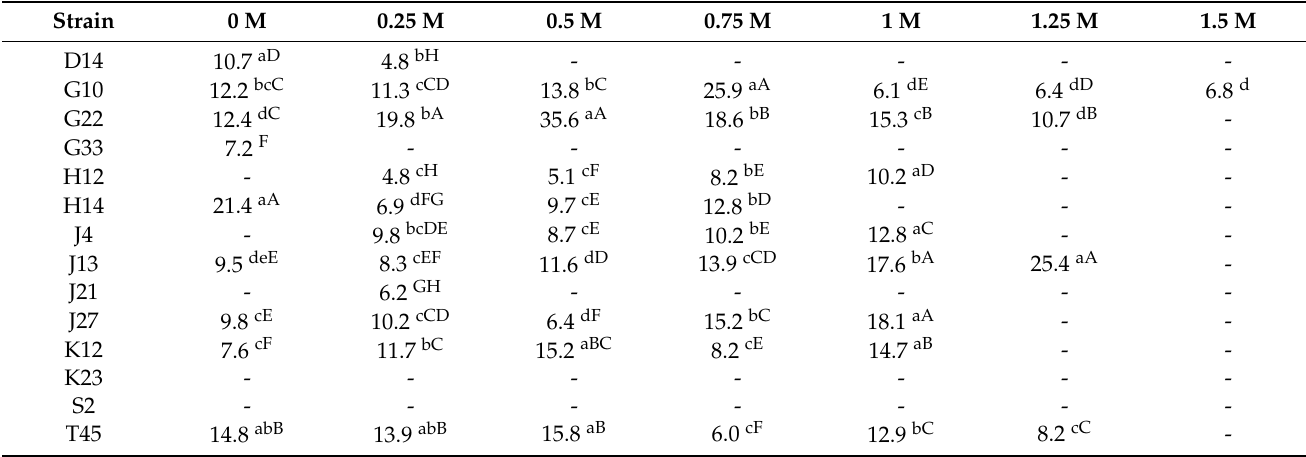
Table 2. Concentrations of indole acetic acid (IAA) ( µ g mL − 1 ) produced by actinomycetes strains under different salt